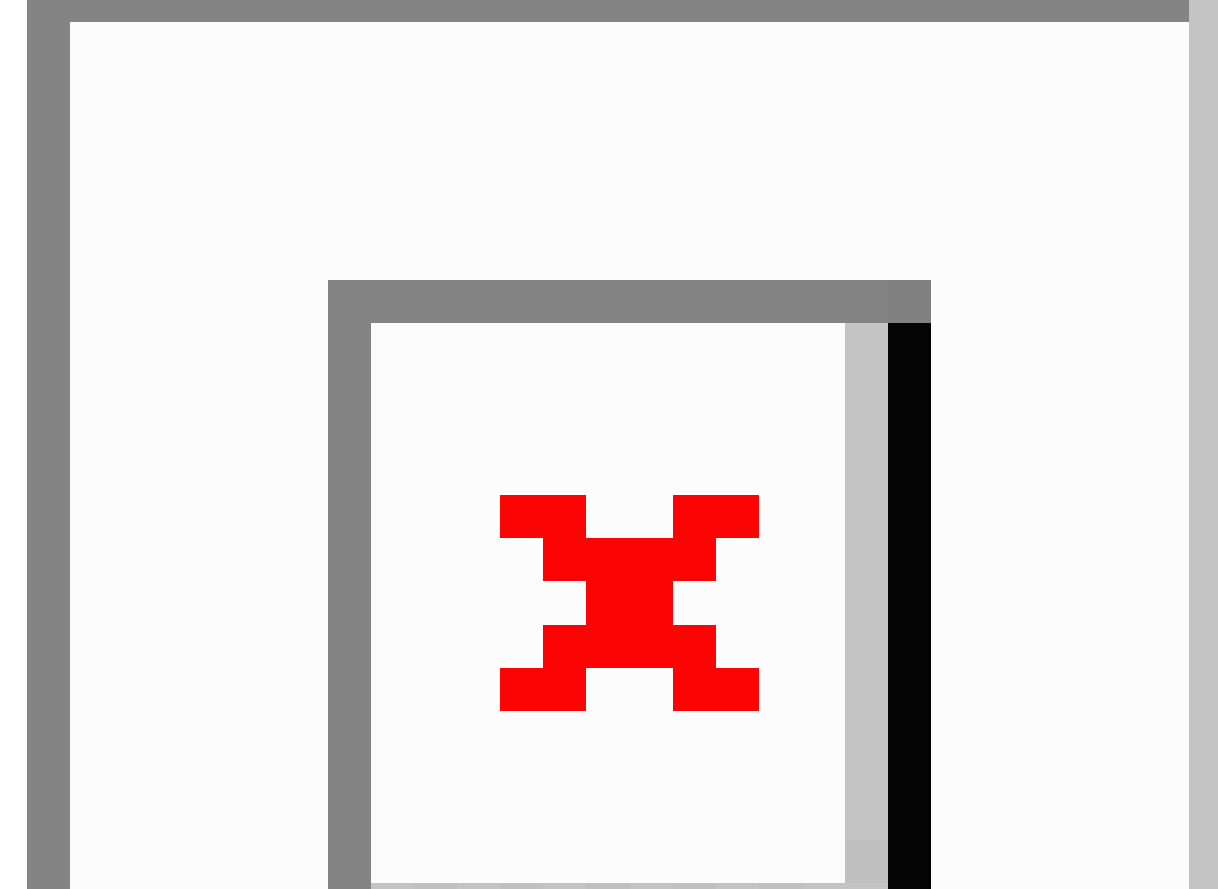
Figure 11. Statistical differences in the different score intervals in the final written pathology examination results. *: statistical significance; ns: no statistically significant